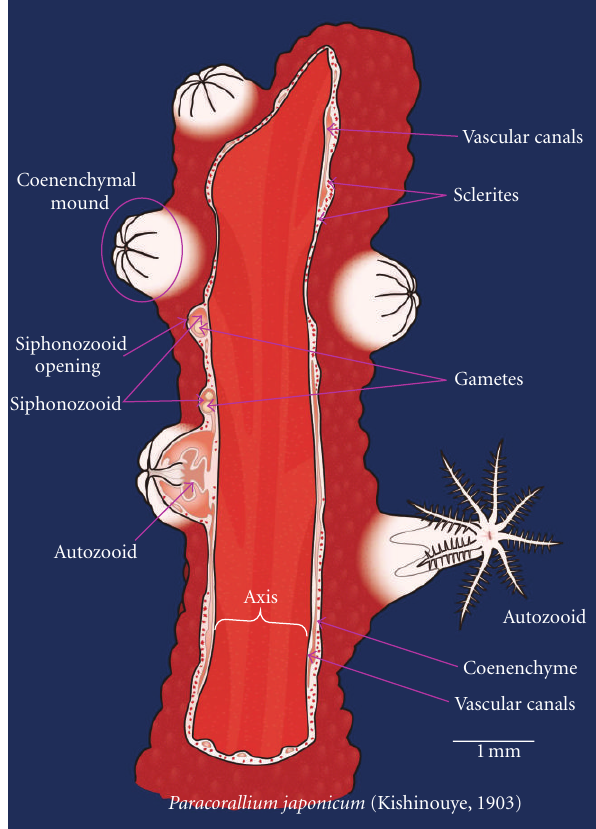
Figure 14: Diagrammatic section through a branchlet of Paracoral- lium japonicum , showing coenenchyme and axis. The coenenchyme of this species is so thin that canal systems are drawn more simply than in actuality.